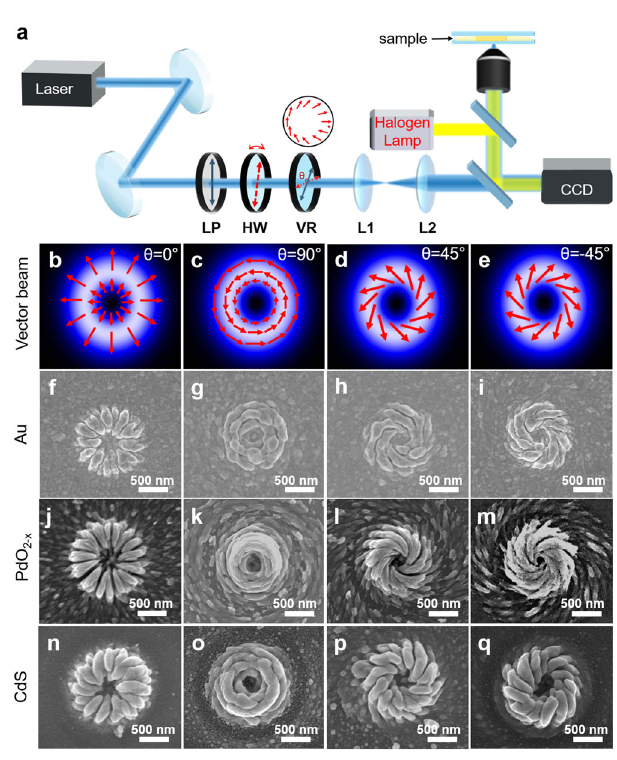
Fig. 3 | Polarization-directed growth of complex (chiral) patterns via vector beams. a Schematic of experimental setup. LP: linear polarizer. HW: half-wave plate.VR:vortexretarder,whichcancreatepolarizationvortices.Theredarrowsin the circle represent the distribution of polarization direction on the vortex plate with red dots indicating the fast axis. Blue line represents the polarization and red line represents the fast axis of the VR. L1/L2: beam expander. b – e Simulated beam pro fi le with different vectors. The angle ( θ ) between the polarization and the fast axis of VR are b 0°, c 90°, d 45°, e − 45°. The red arrows are indicators for polar- izationorientation. f – q CorrespondingSEMimagesofthecomplex(chiral)patterns formed with different vector beams. f – i Au, j – m PdO 2 − x , n – q